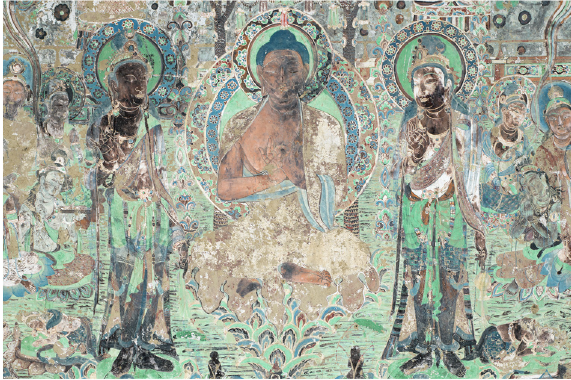
Figure 1. Mogao Cave 220, south wall, Amitabha